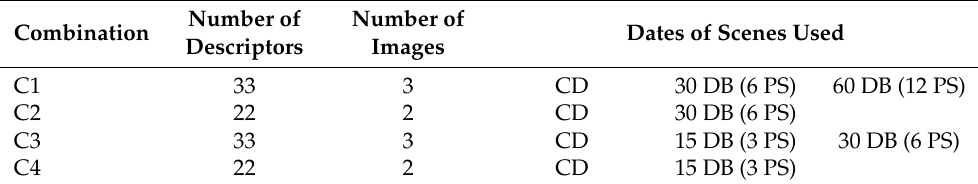
Table 4. Combinations and number of scenes used in each